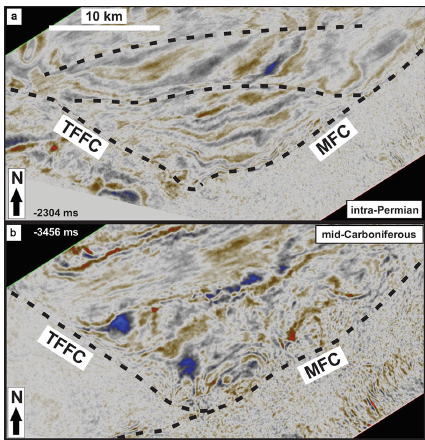
Figure 8. (a) Intra-Permian seismic time slice within 3-D seismic survey MC3D-MFZ02 in the southwesternmost Nordkapp basin. Dashed black lines correspond to interpreted brittle faults; (b) seis- mic time slice within 3-D seismic survey MC3D-MFZ02 near the interpreted mid-Carboniferous reflection in the southwesternmost Nordkapp basin. Black dashed lines represent interpreted brittle faults. See Fig. 2 for